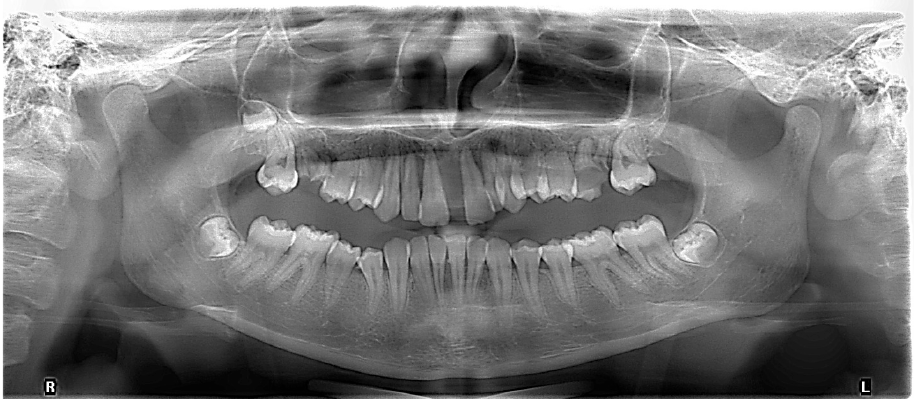
Figure 3. Initial panoramic